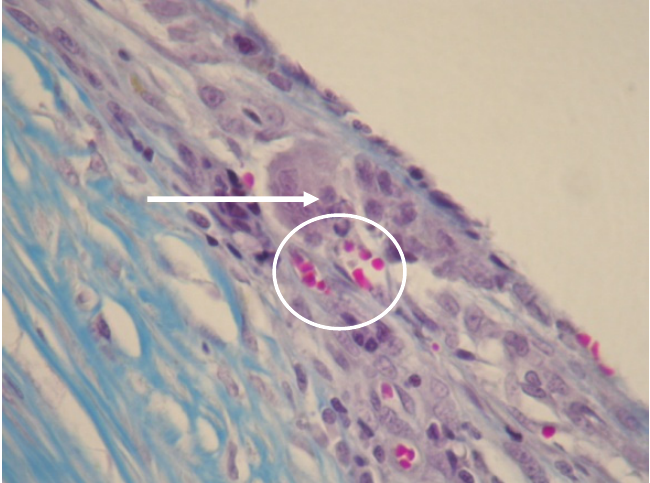
FIGURE 5 – Light photomicrograph obtained on the 28th day after surgery in the left inguinal region of dog number 6 (latex biomembrane with impermeable polyamide). Vascular neoformation is observed (circle), as well as a chronic lymphohistiocytic inflammatory process (arrow), organized collagen deposition and a cyst. No fibrosis occurred (Masson trichrome, 400x)